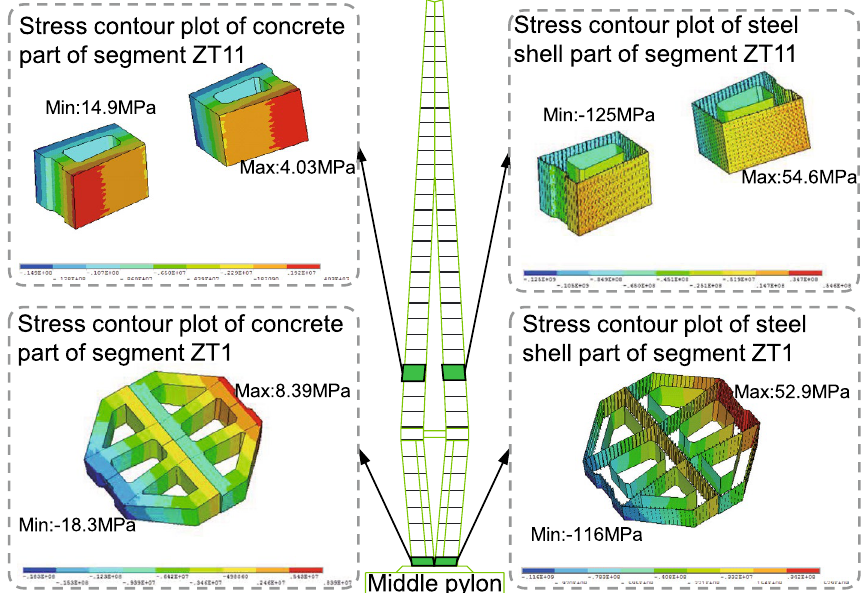
Figure 7. The most unfavorable calculation result of the pylon under the service limit state.